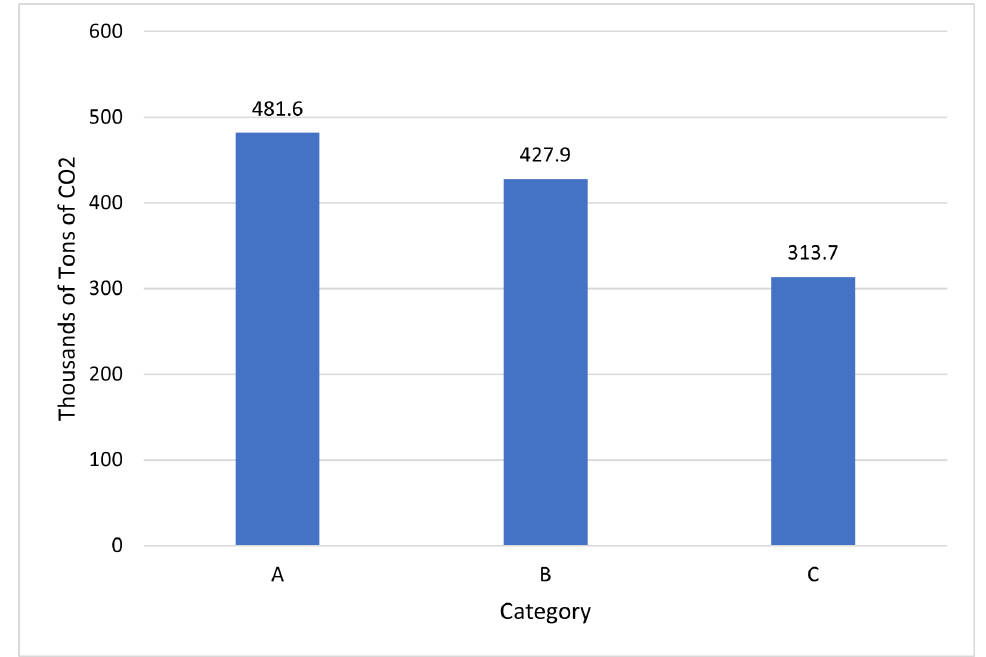
Figure 14. Avoided CO 2 emissions at country